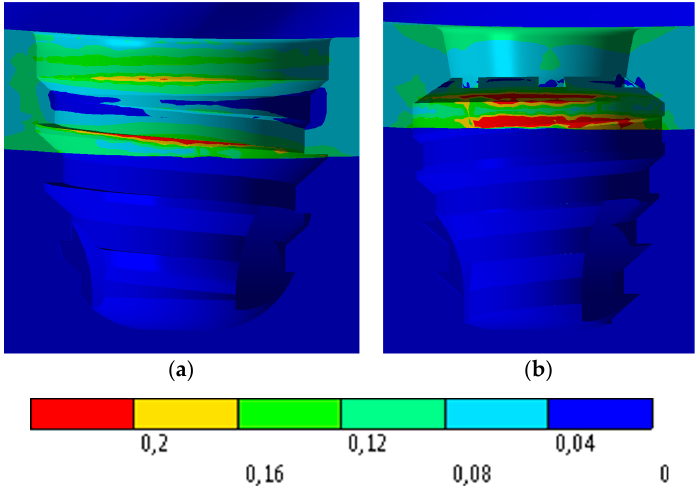
Figure 10. Stress distribution on bone with an axial load: ( a ) IH connection; ( b ) MT connection. Bone stress distribution with the oblique stress is detailed in Figure 11.